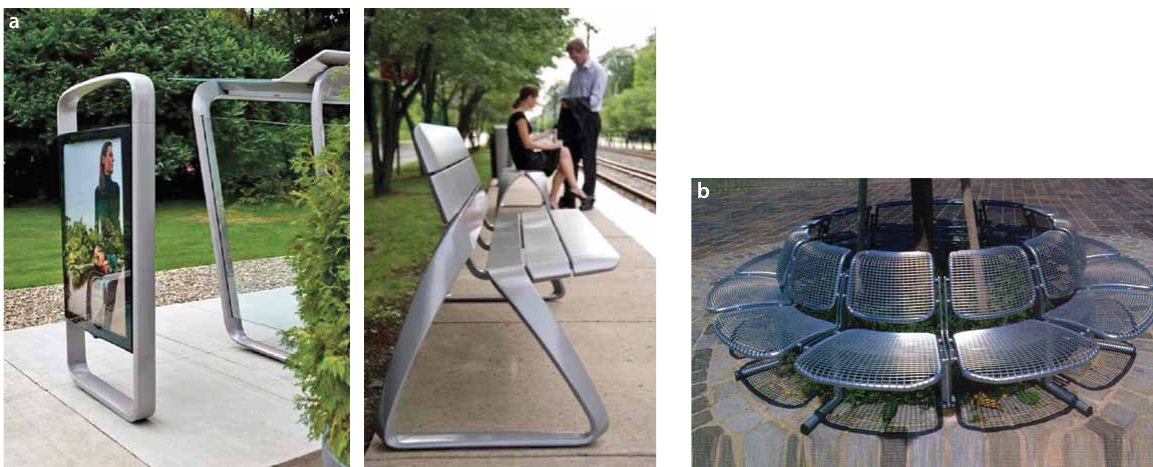
Fig. 7. objects of street design from stainless steel in the towns of Europe: a – public transport stop with a set of furniture designed by company “Metro 40”; b – wire netting rest bench covered with